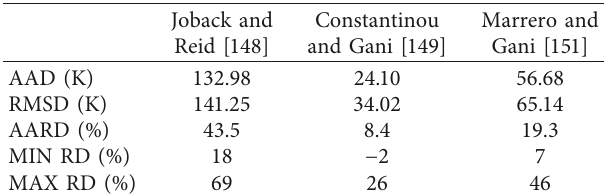
Figure 5: Absolute relative deviation comparison for the normal melting point estimation. Table 9: Deviations of different methods for the estimation of the normal melting